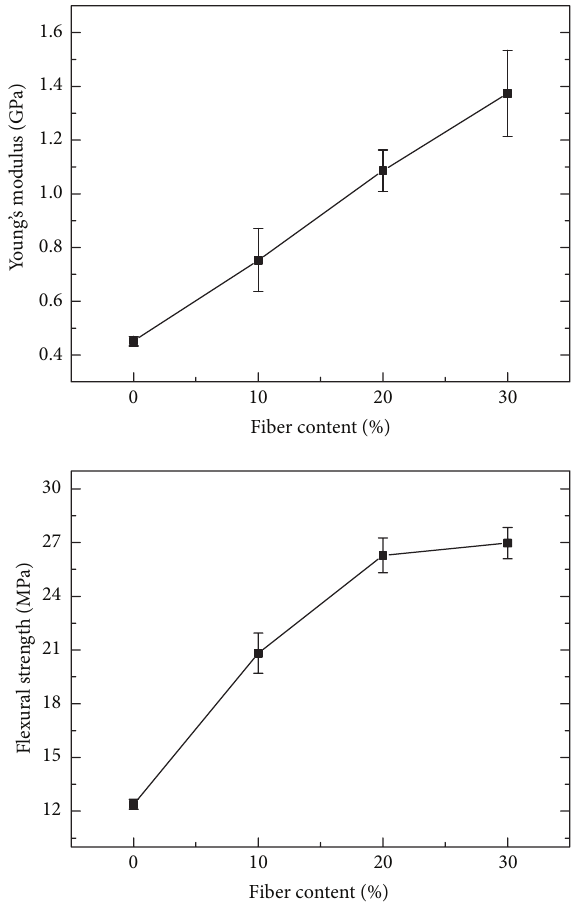
Figure 4: Flexural properties of the materials evaluated.